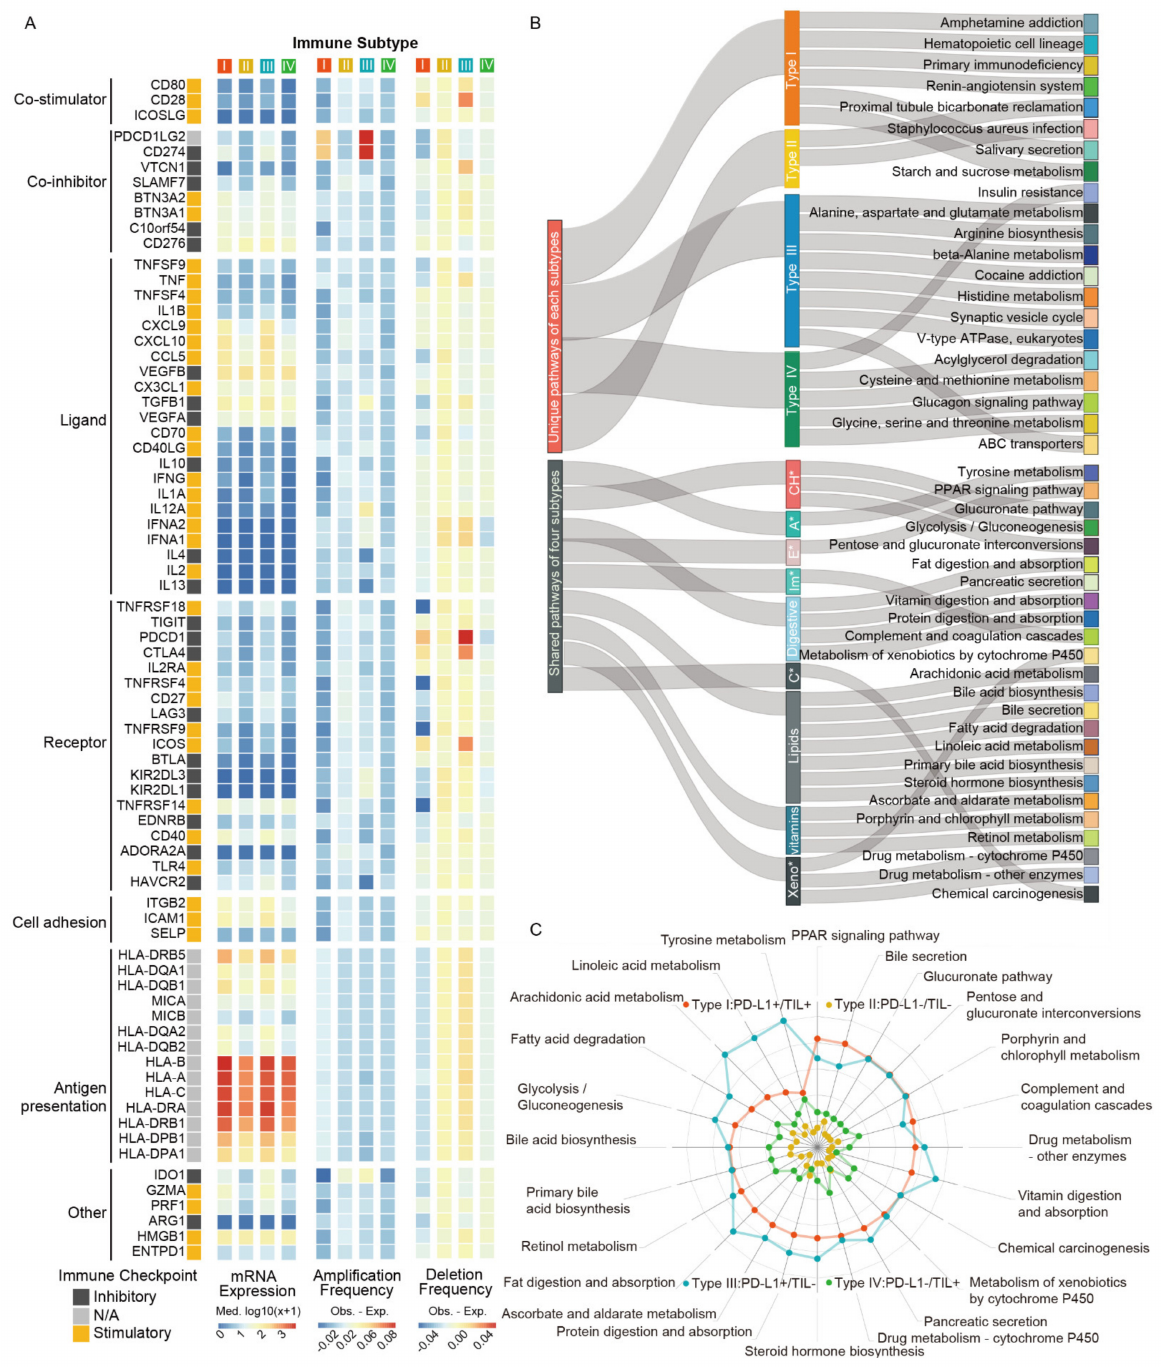
Figure 4. The transcriptomic pattern discrepancy in four TIME subtypes. ( A ) The immunomodulators gene expression and copy number variation for each subtype. ( B ) The shared and unique pathway features for each subtype. ( C ) The distinct difference weight score of pathways in each group. Abbreviations: CH*: carbohydrates, A*: Amino acid, E*: Endocrine, Im*: Immune, C*: Cancer, Xeno*: